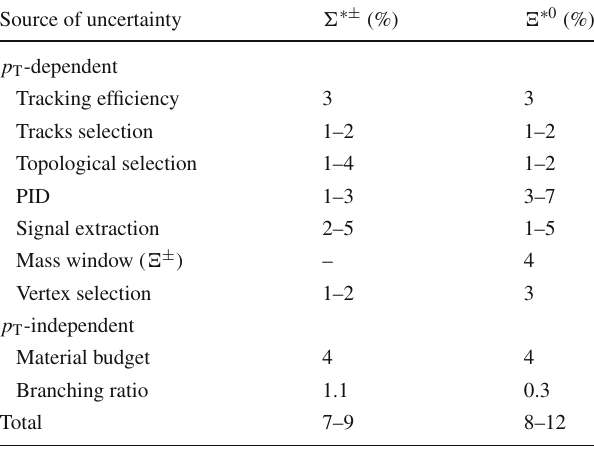
Table 5 Summary of the systematic uncertainties on the differential yield,d 2 N /( d p T d y ) .Minimumandmaximumvaluesinall p T intervals and multiplicity classes are shown for each source